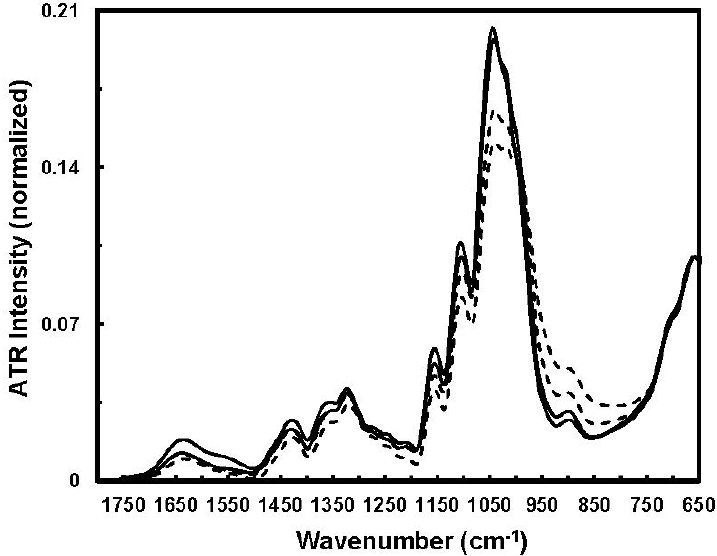
Figure 8. Typical ATR-FTIR spectra of immature (solid line) and mature (dashed line) fibers (Reprinted with permission from [24]. Copyright 2012 Ingentaconnect).